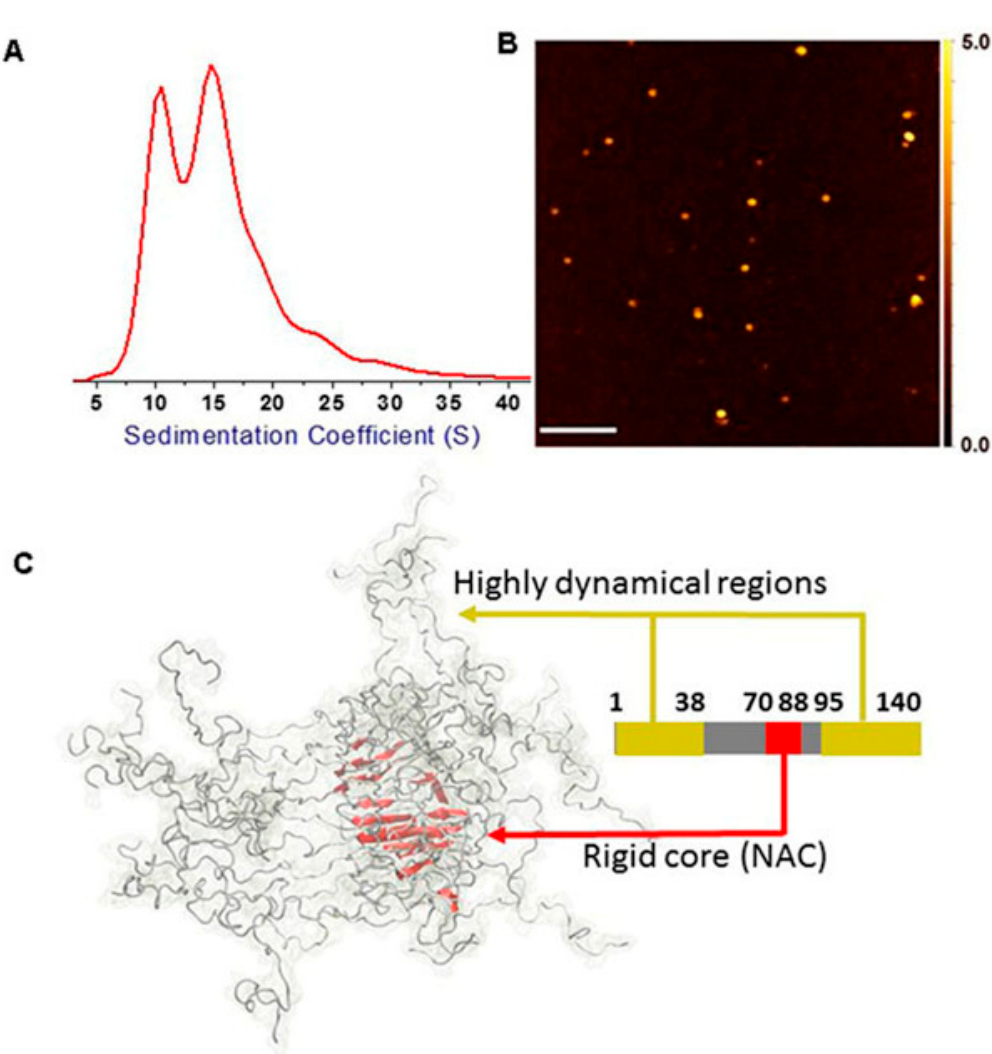
Figure 1. Structural properties of H- α SynOs employed in this work. The toxic oligomers employed in this work were previously characterized for their structural properties and designated as type-B*